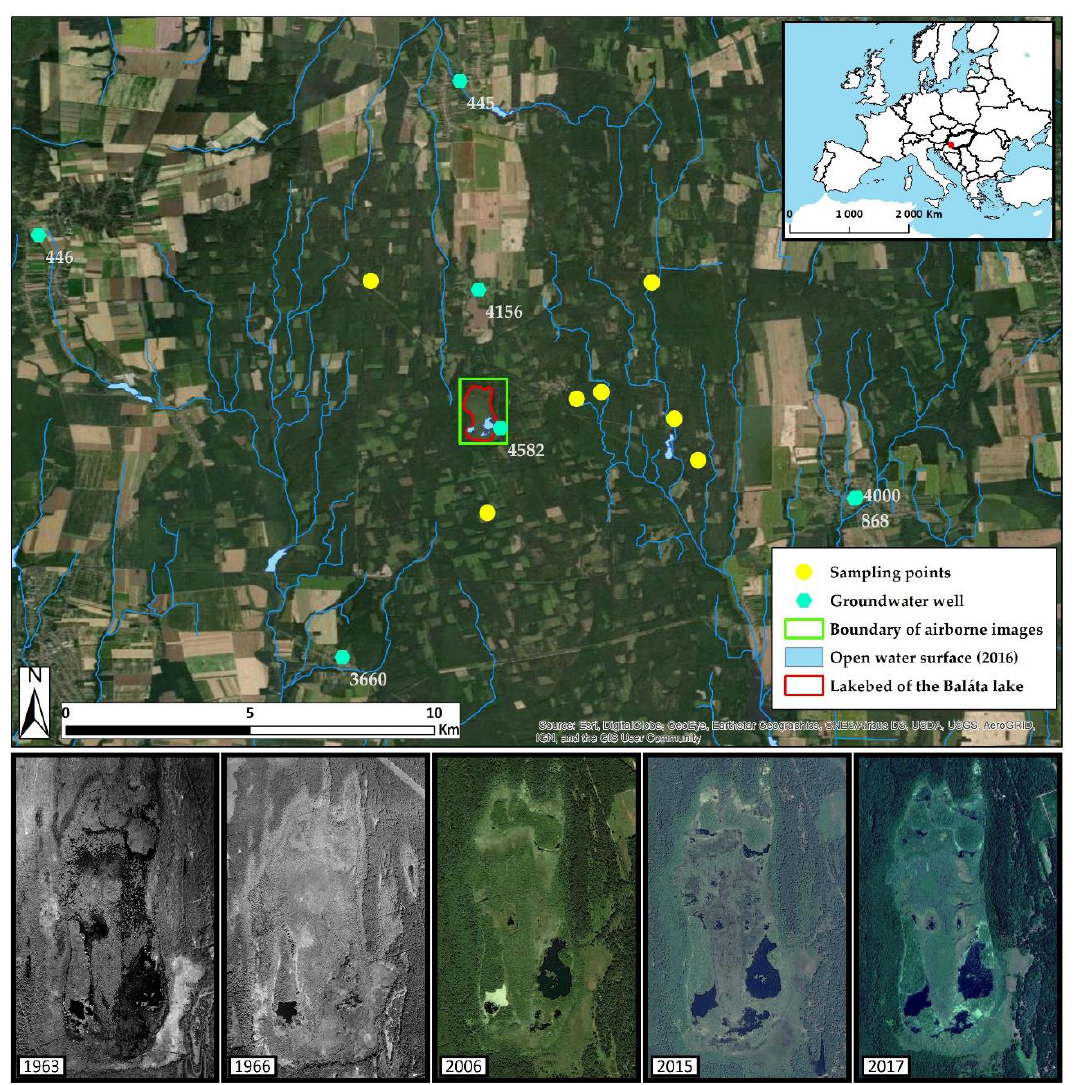
Figure 1. Aerial overview of the study area with its land-cover and hydrographical properties, tree-ring sampling sites, and groundwater wells with available data (main panel), and historical aerial images of the Lake Baláta and its changing open water surface, a key hydrographic and conservational feature of the Szenta Forest (below). Source of imagery: [27-28]